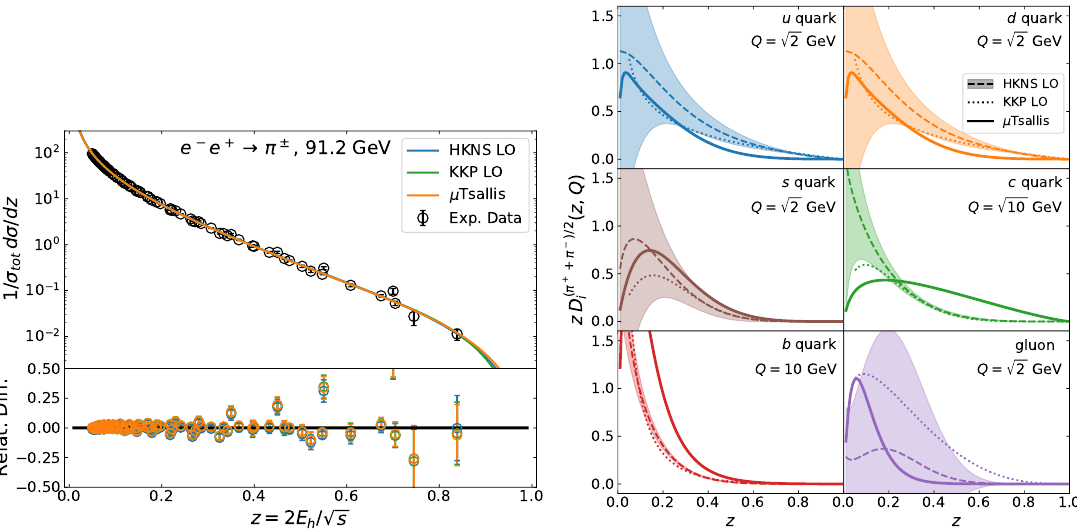
Figure 1. ( Left ): The microcanonical Tsallis FF parametrization in pion spectrum from Ref. [10]. HKNS and KKP labels two LO calculations using polynomial FF from Ref. [10,11]. ( Right ): The microcanonical Tsallis FF parametrization compared to HKNS with uncertainty and KKP FFs for different partonic channels at a given Q